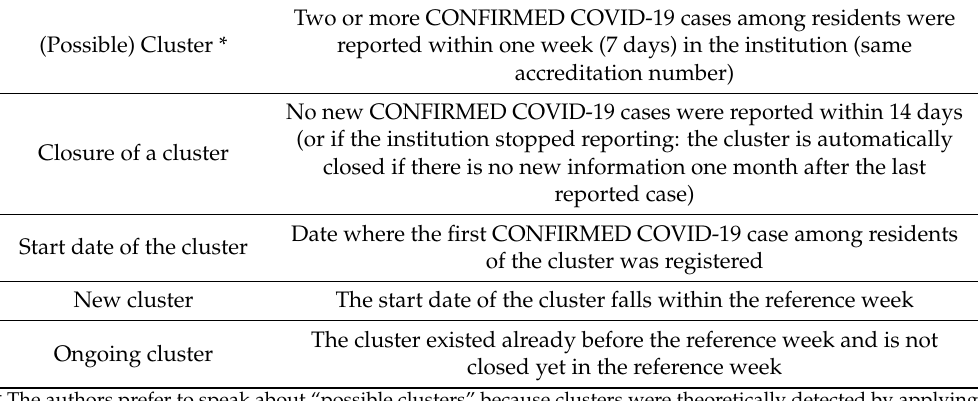
Table 1. Definitions applied to calculate possible